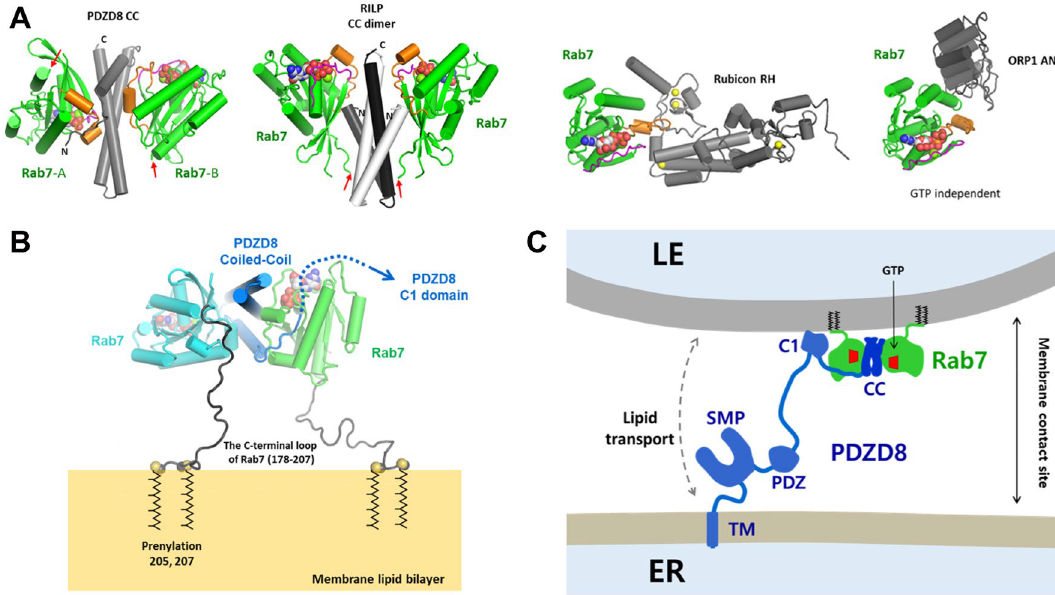
Figure 4. Schematic model of PDZD8 function at the LEL–ER membrane contact site. ( A ) Overall structures of Rab7 and its effector protein complexes. The structures of the PDZD8 CC–Rab7 (this study), RILP–Rab7 (PDB id: 1YHN) 14 , Rubicon RH–Rab7 (PDB id: 6WCW) 21 , and ORP1L–Rab7 (PDB id: 6IYB) 22 were shown to compare the binding modes of the effector proteins. Rab7 and the effectors were colored in green and gray, respectively. The bound-GTP was shown in a sphere model. The red arrows indicate the C-termini of the Rab7 molecules. ( B ) Structural modeling of the PDZD8 CC–Rab7 complex on the lipid membrane. The C-terminal flexible loops (residues 178–195) of Rab7 invisible in the experimental structure were modeled with gray loops. The prenylation of the Rab7 residues at 205 and 207 was shown in thick lines. The upstream of the PDZD8 CC were indicated by blue dotted lines. The structure of the PDZD8 CC–Rab7 complex was oriented so that the C-terminal loop regions of two Rab7 molecules contact the lipid membrane at the same distance. ( C ) Schematic model of PDZD8 function at the LE–ER membrane contact site. The prenylated Rab7 localizes to the LE/ lysosomal membrane. PDZD8 associates with two molecules of GTP-loaded Rab7 in the LE membrane by its coiled-coil domain. The PDZD8 contains an N-terminal transmembrane helix that anchors the protein to the ER and the C1 domain that binds PI(4)P and phosphatidylserine in the membranes 9 . The SMP domain of PDZD8 might transport various lipids between the